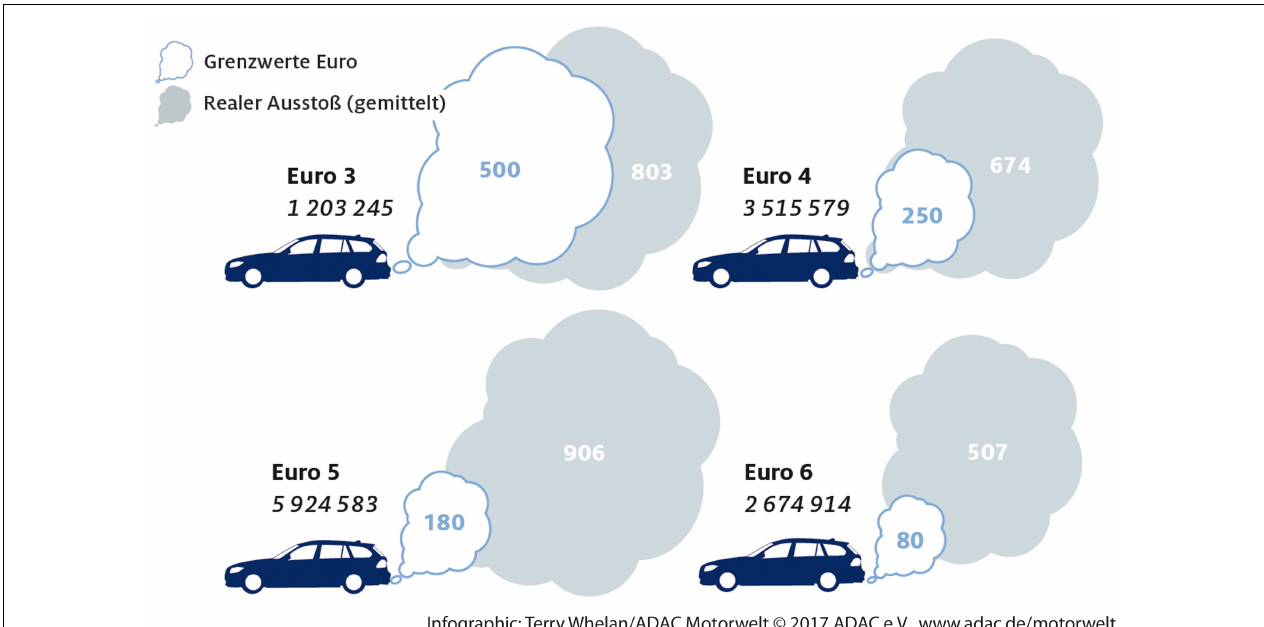
FIGURE 1 | Pictorial chart of the nitrogen oxide emission of cars in a German magazine (Allgemeiner Deutscher Automobil-Club, 2017, p. 14). Copyright 2017 by Allgemeiner Deutscher Automobil-Club. Reprinted with permission (Grenzwert Euro: threshold value Euro norm, realer Aussto β : actual emission).